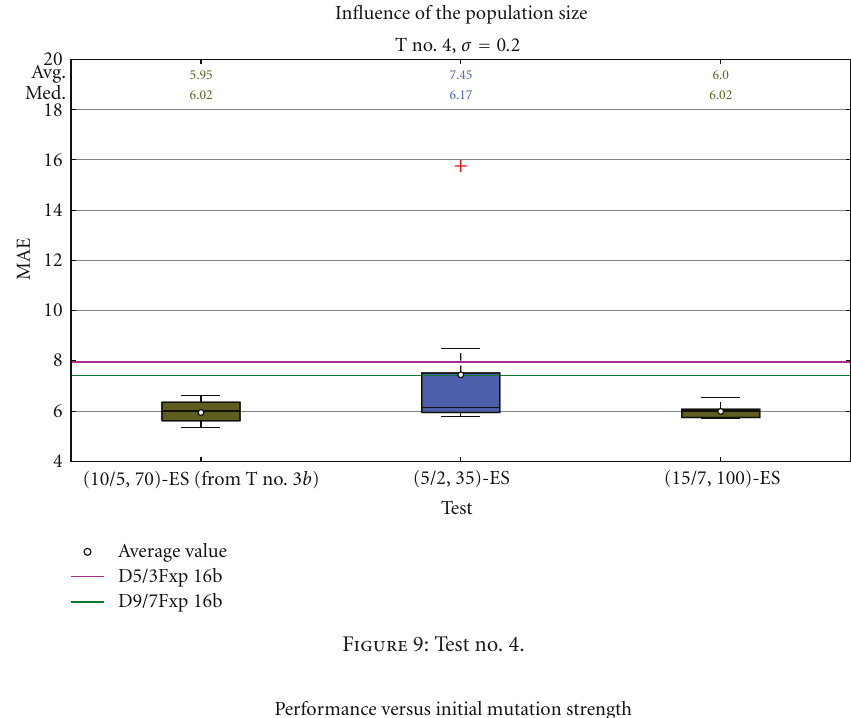
Figure 9: Test no. 4.